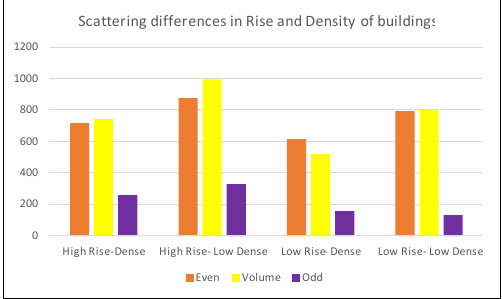
Figure 8: Variation of scattering power with respect to rise and density of buildings